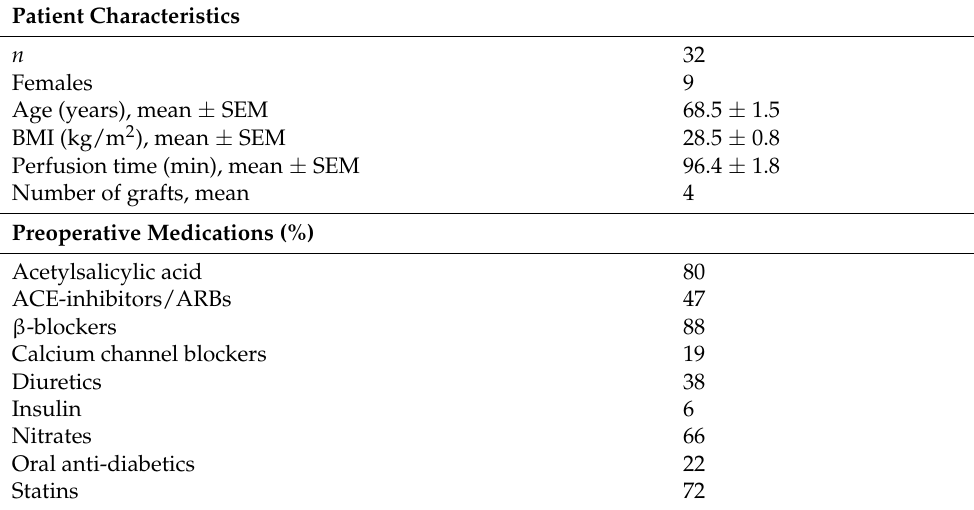
Table 1. Demographic